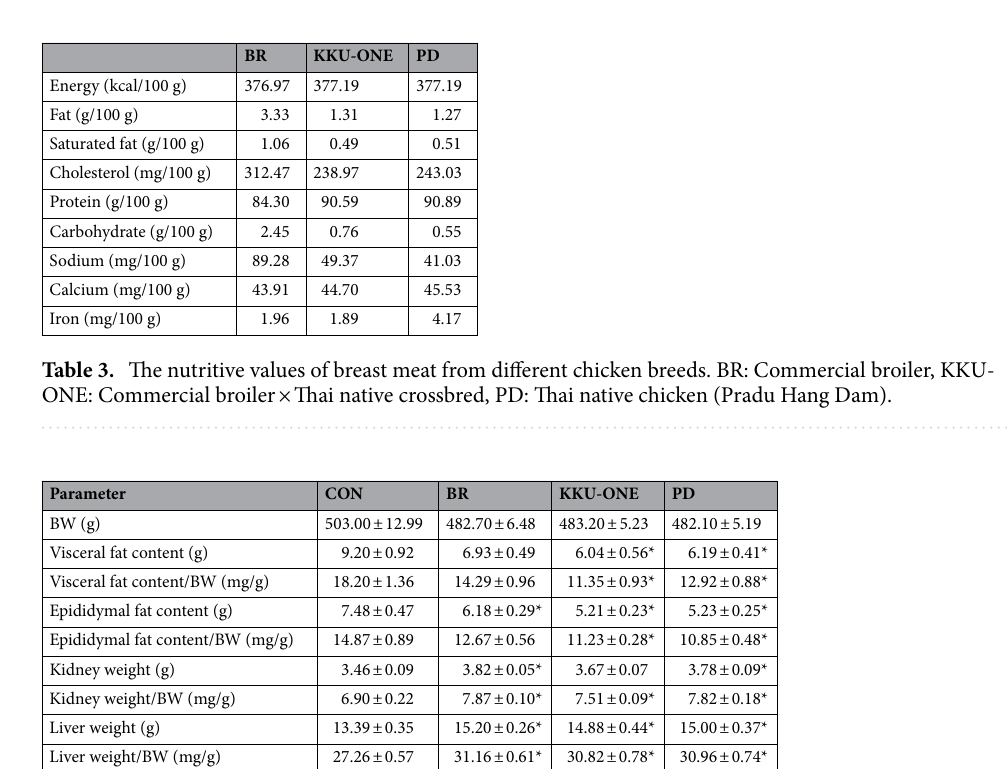
Table 4. Effect of a high protein diet comprising breast meat from different chicken breeds on body and organ weight of rats. Data are expressed as the mean ± SEM. (n = 8 animals/group); * p < 0.05 vs. CON; BW: body weight; BR: commercial broiler group, CON: control group, KKU-ONE: commercial broiler × Thai native crossbred group, PD: Thai native chicken (Pradu Hang Dam) group.